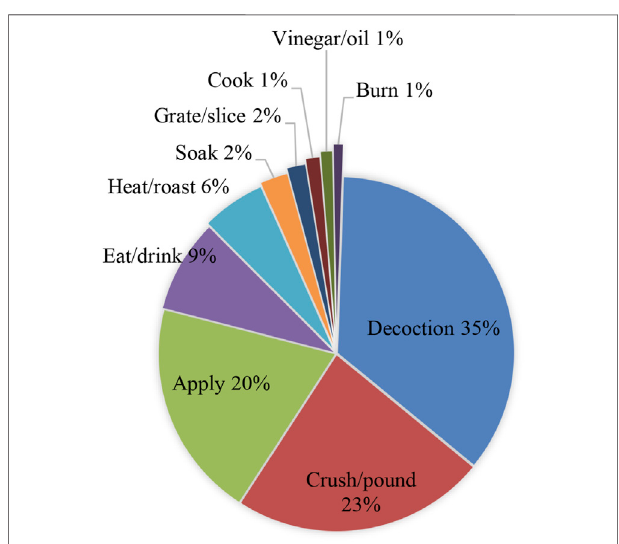
FIGURE 5 | Medicinal plant